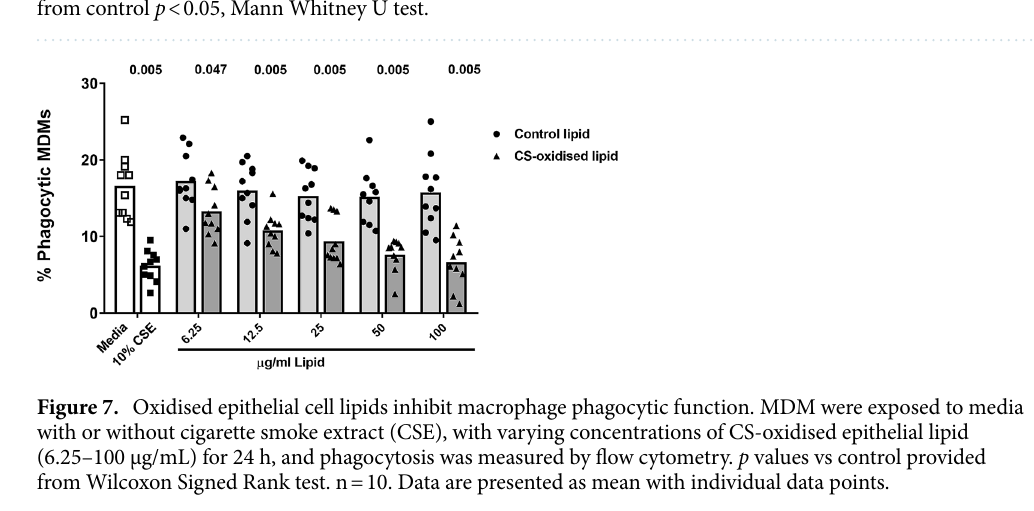
cigarette smoke, including ceramide overproduction, an upregulation of a range of sphingosine-1-phosphate (S1P) signalling-related genes including sphingosine kinases, but downregulation of their enzyme activity and subcellular redistribution in macrophages 62,63 . We also showed that a change in sphingosine pathway was likely involved in reduced efferocytosis and bacterial phagocytosis seen in COPD patients and macrophages exposed to cigarette smoke 39,40 . Hughes et al., found increased sphingomyelins in the BAL of smokers vs never-smokers 64 and Telenga et al., showed that a range of sphingolipids, including sphingomyelins was increased in the sputum of current smoker COPD patients vs smokers and then reduced upon cessation of smoking in both groups 65 . The suggestion that the sphingosine pathway may be involved in an autoimmune component of COPD is fur- ther supported by the fact that modulation of the sphingosine pathway is in preclinical and clinical trials for a